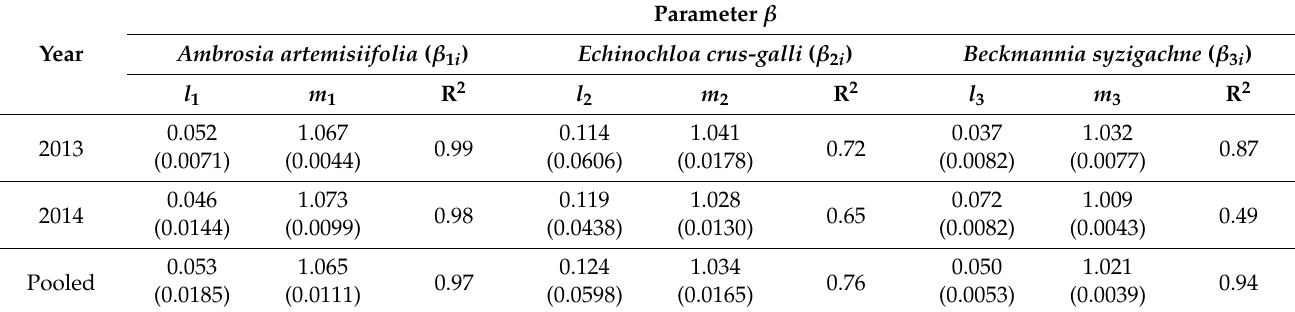
Table 2. Parameter estimates for the exponential model for the regression of weed competitiveness of Ambrosia artemisiifolia ( β 1 i ) , Echinochloa crus-galli ( β 2 i ), and Beckmannia syzigachne ( β 3 i ) as a function of applied nitrogen in 2013 and 2014 and for the pooled two-year data presented in Table 1. The numbers in parentheses are standard